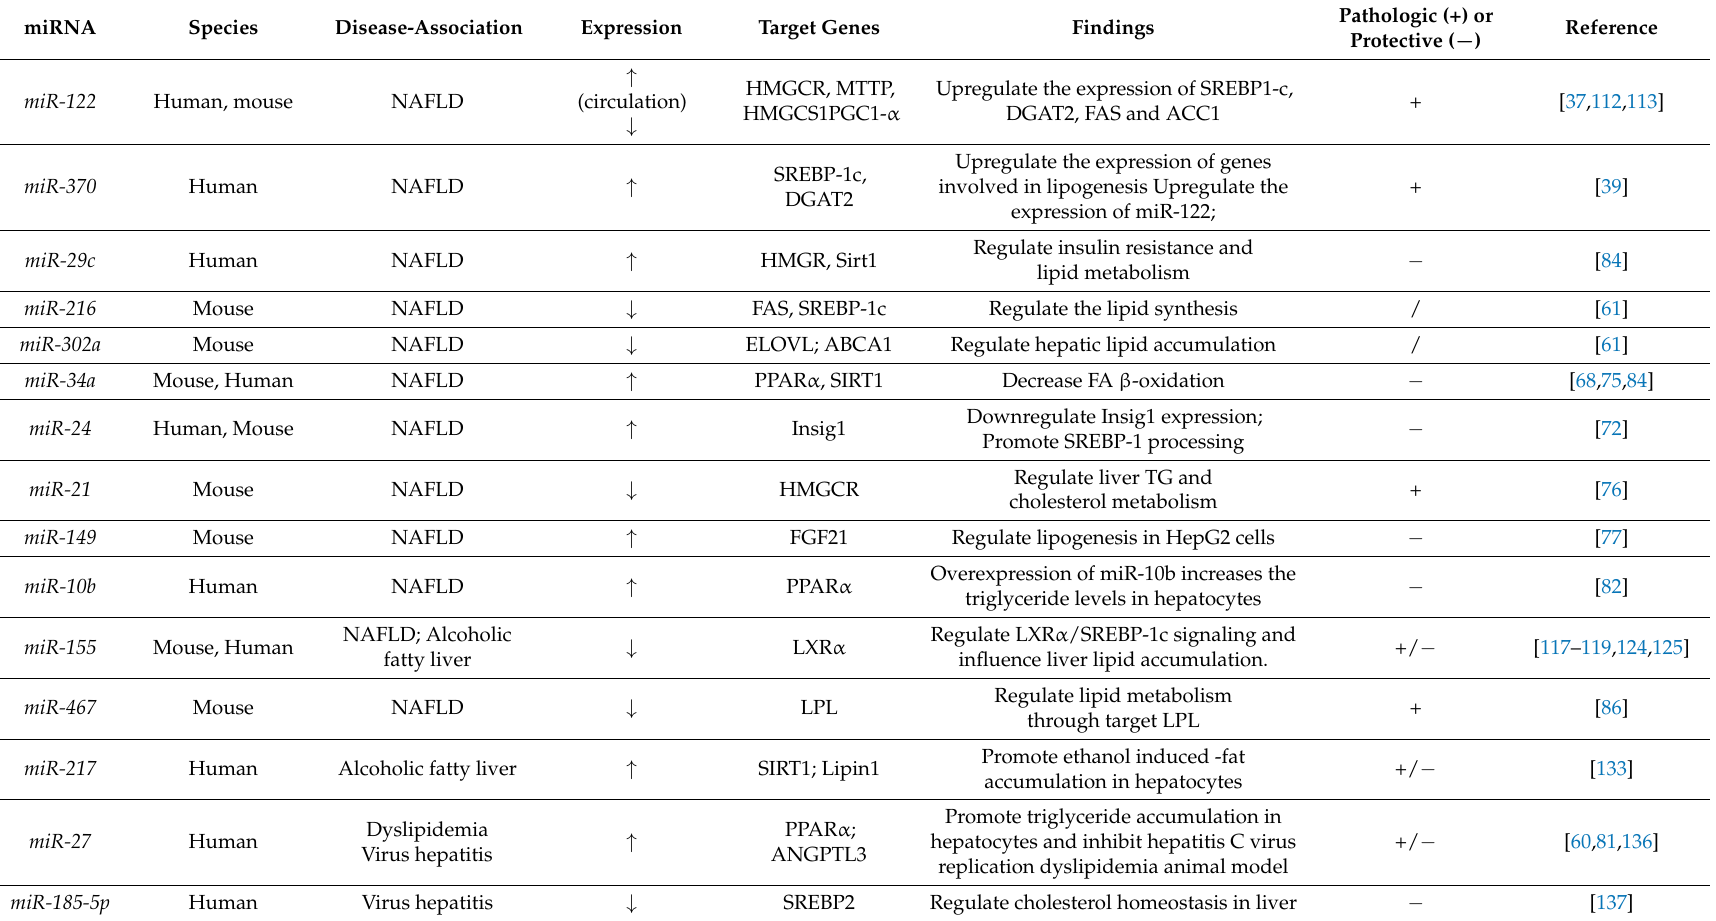
Table 1. Summary of recently reported miRNA studies in fatty liver